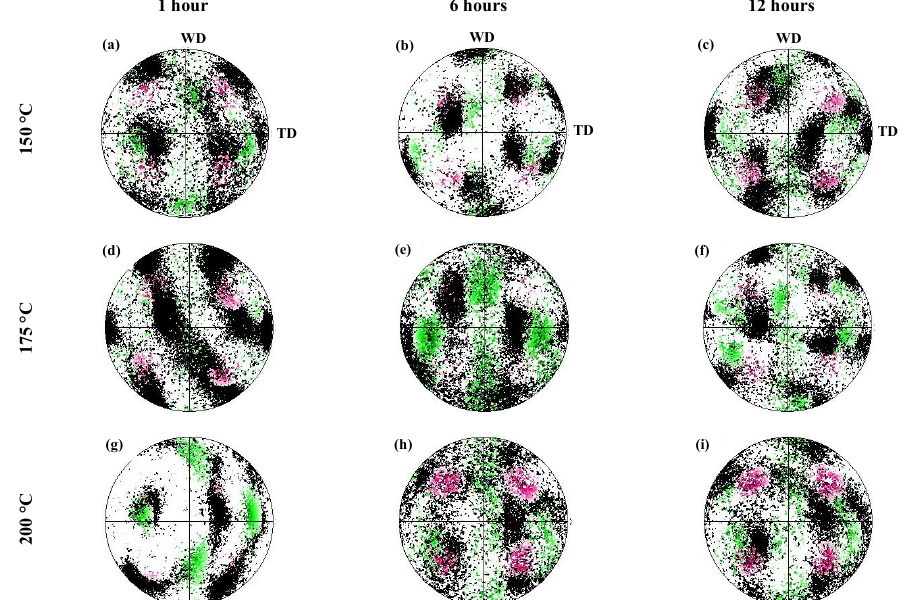
Figure 11. {1 1 1} pole figures of FSP samples aged at: ( a – c ) 150 °C; ( d – f ) 175 °C; and ( g – i ) 200 °C. Texture components: green ( B fiber), red (Cube).